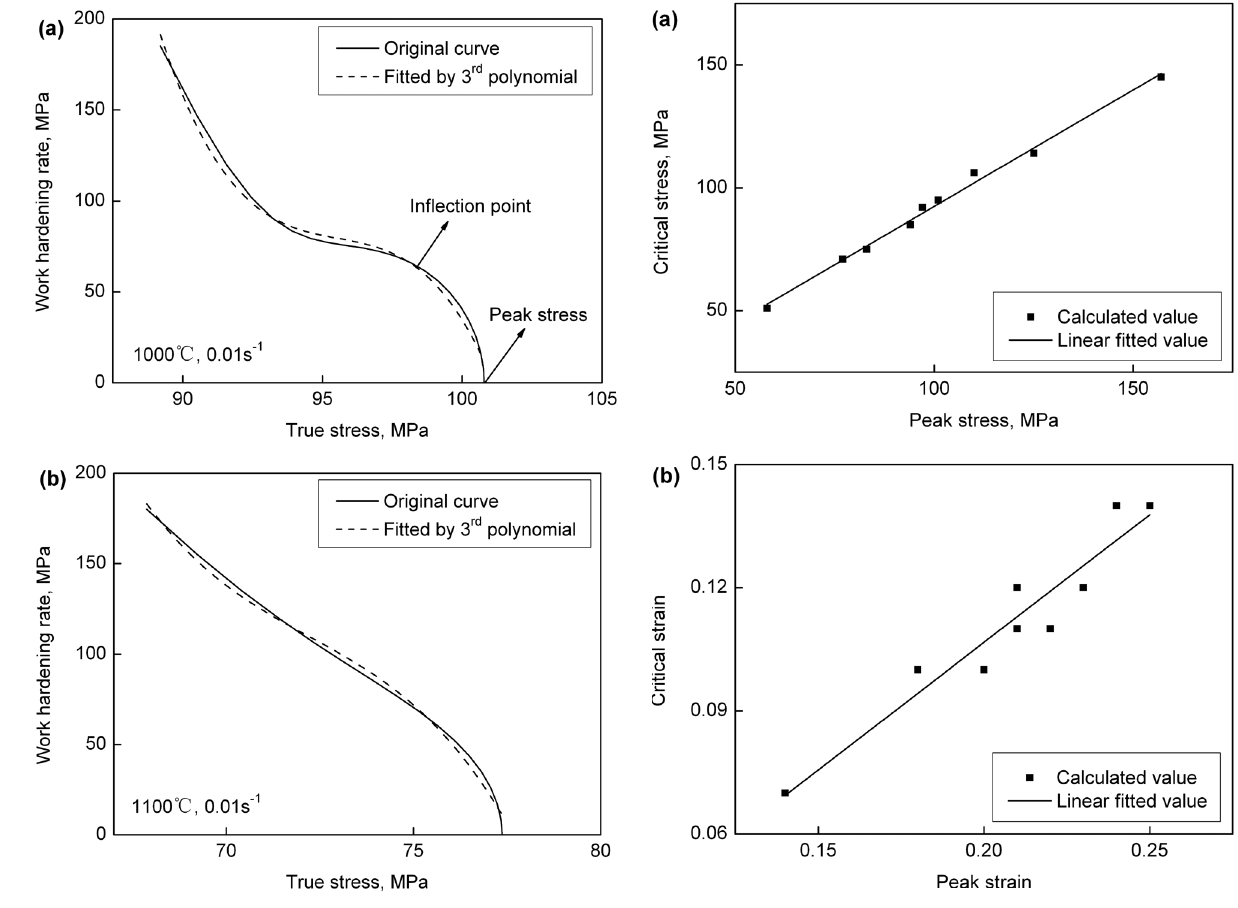
Fig. 8: θ - σ curves and its corresponding third order polynomial for 0.01 s − 1 at (a) 1000 °C and (b) 1100 °C.